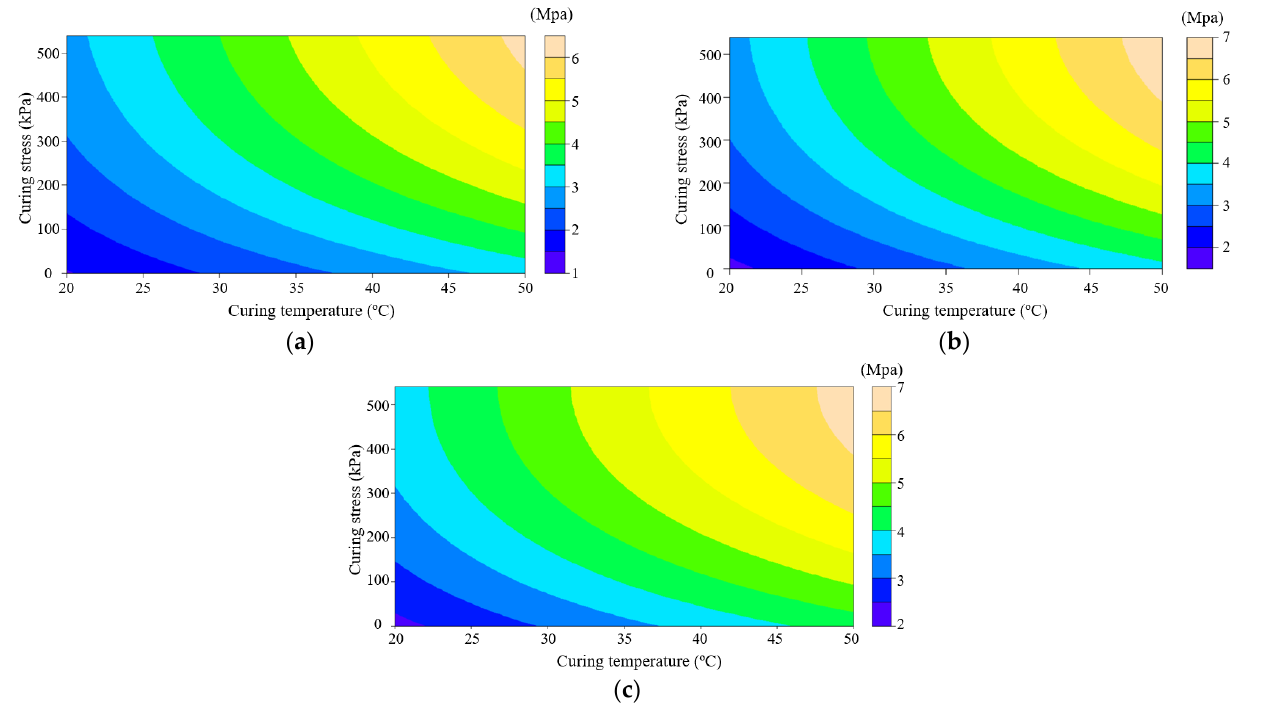
Figure 6. The theoretical model of the UCS contours for CPB: ( a ) 7d; ( b ) 14d; ( c ) 28d.